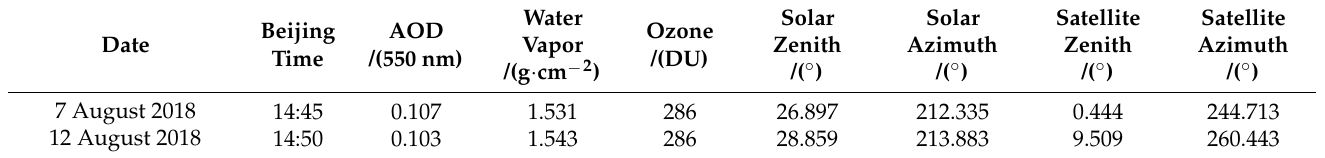
Table 8. Atmospheric and geometric parameters of FY-3D/MERSI-II at the Dunhuang RCS. Beijing